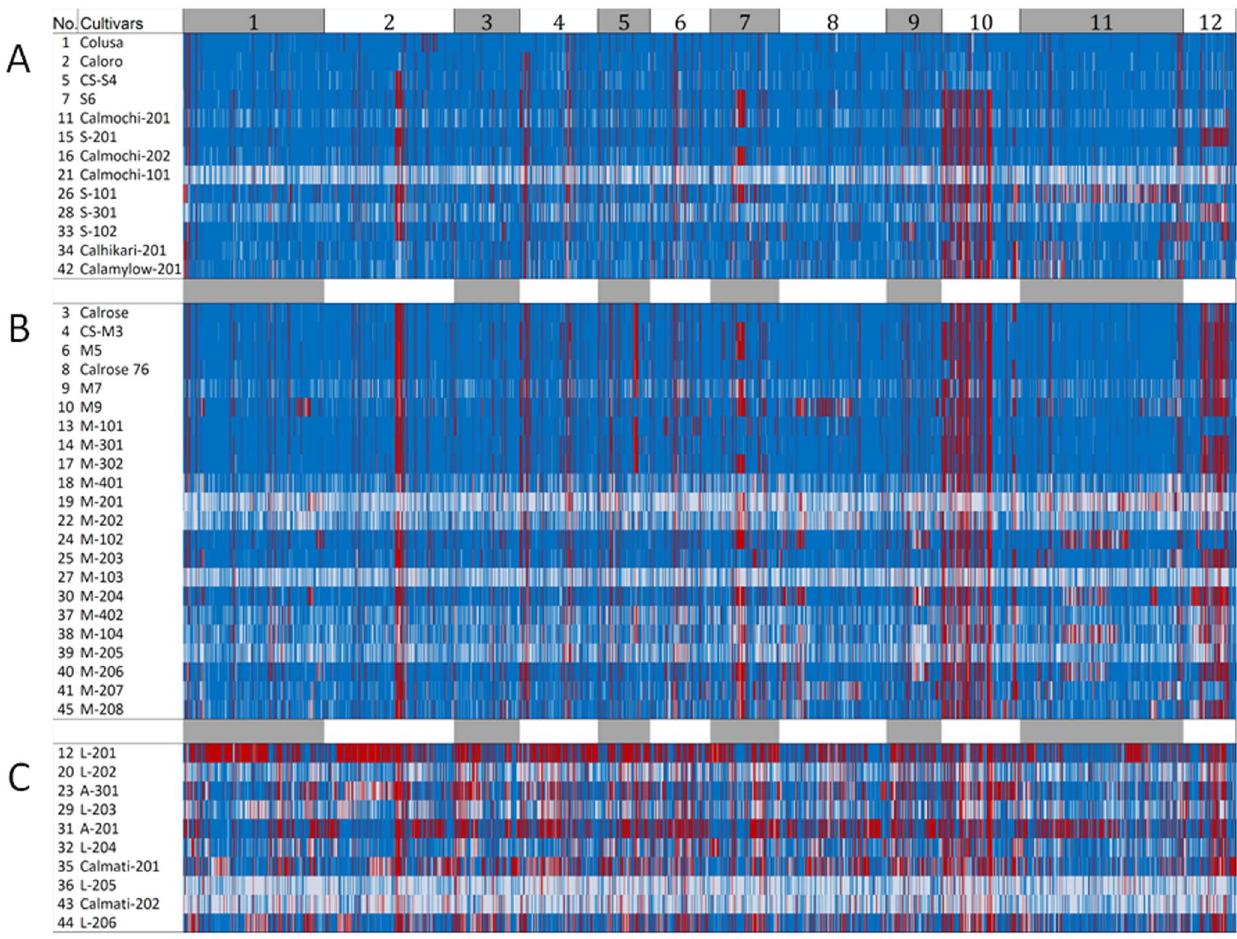
Figure 3. High-density haplotype maps of 45 California cultivars generated by RESCAN. (A) short grain (B) medium grain (C) long grain Regions in blue are monomorphic with regard to the Nipponbare reference genome. Regions in red represent haplotype blocks and white areas represent missing data.